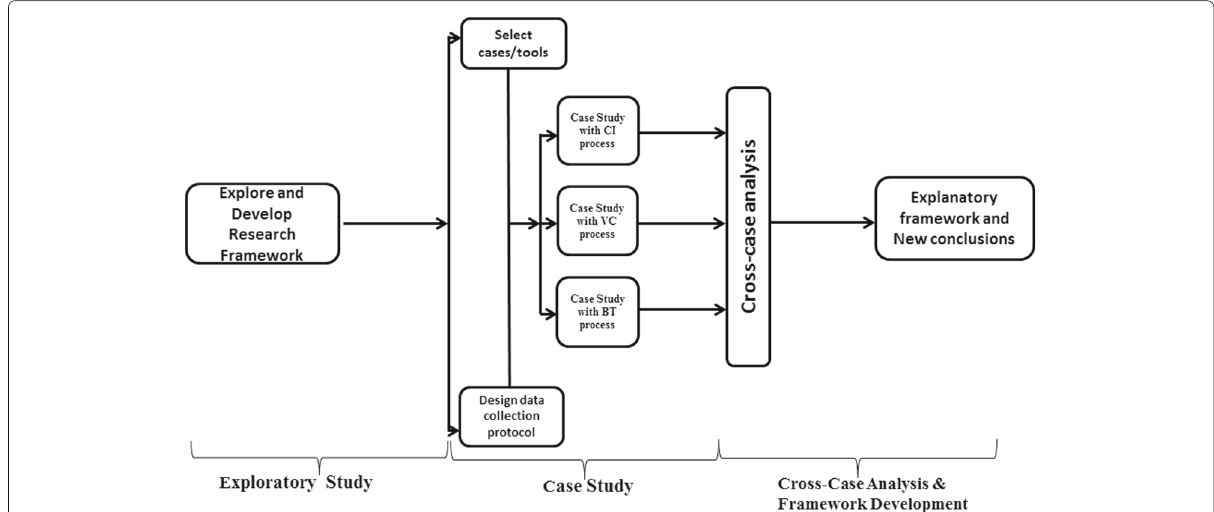
Fig. 2 Overall research